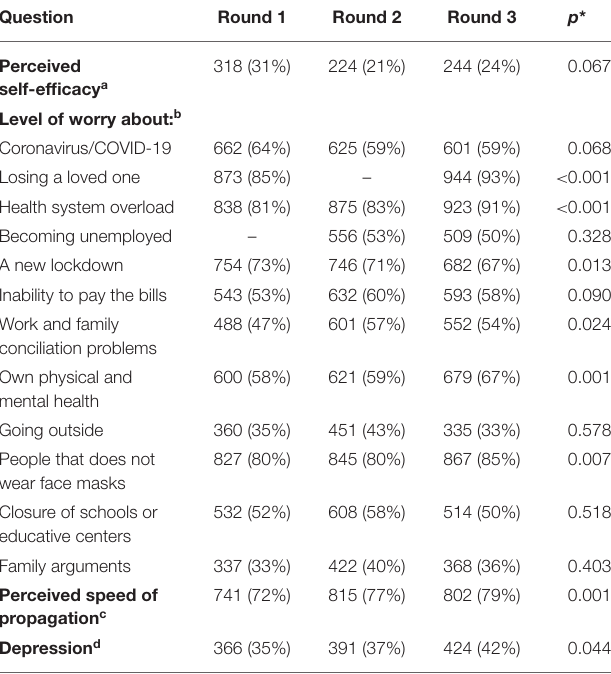
TABLE 6 | Psychological variables in each